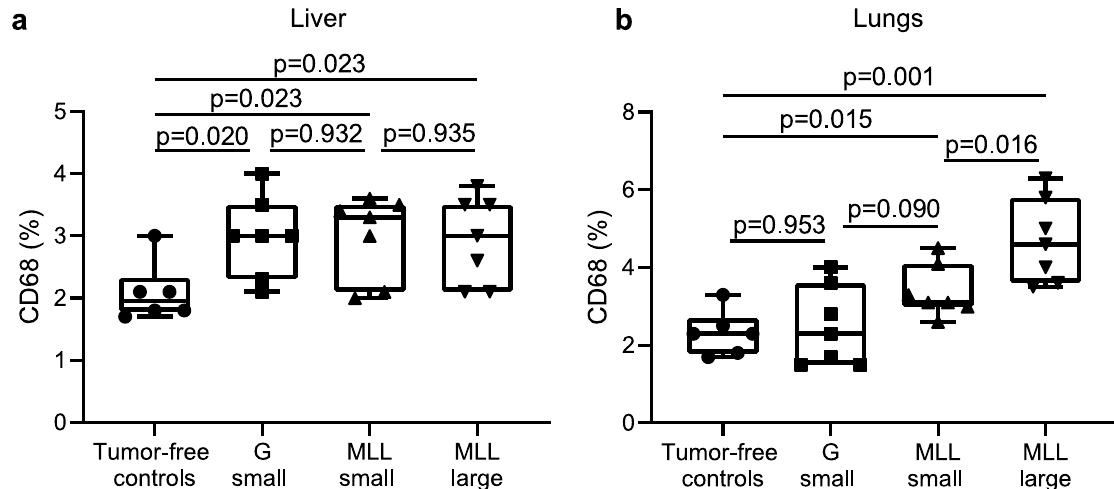
Figure 3. Macrophage densities in liver and lungs in animals with intraprostatic tumors. Box plots showing the volume density (%) of CD68 + cells in livers ( a ) and lungs ( b ) in animals with intraprostatic G- or MLL-tumors. The density of CD68 + cells was significantly increased in lungs by MLL-tumors compared to controls and in a tumor-size dependent way. The non-parametric Kruskal–Wallis H test was used for multiple comparison, if significant (p < 0.05), the non-parametric Mann–Whitney U test was used to compare two